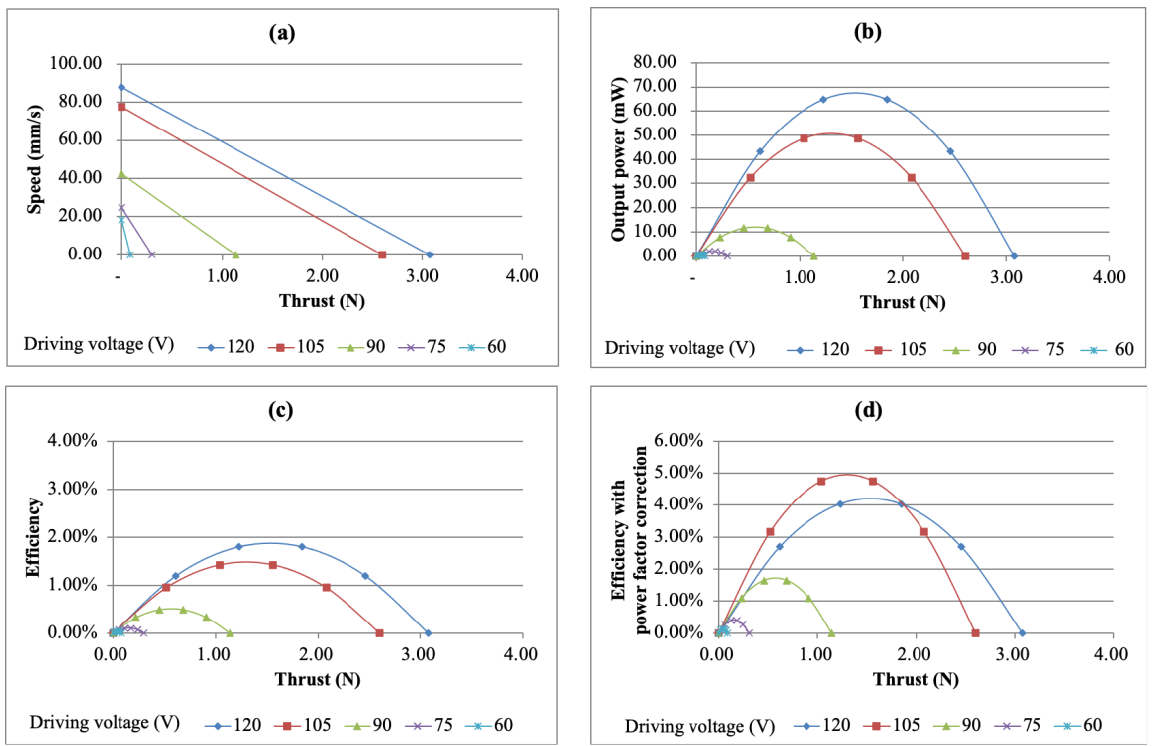
Figure 15. Performance of the simple bimorph USM under different driving voltages. ( a ) Speed vs. thrust curve, ( b ) output power vs. thrust curve, ( c ) efficiency vs. thrust curve and ( d ) efficiency vs. thrust curve with power factor